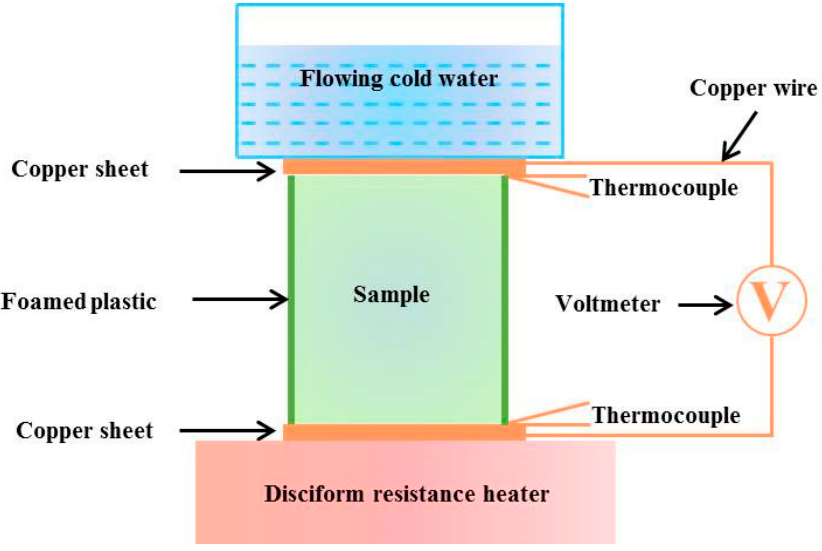
Figure 1. The schematic of the apparatus for measuring Seebeck coefficient around room temperature. The cement-based thermoelectric device mainly included cement-paste blocks (M6), 24 hardened cement-paste blocks (40 × 40 × 160 mm) were connected in series by copper cement-paste block and the copper block to reduce the thermal resistance. In addition, the side of the cement-paste block was covered with a layer of foam insulation to reduce heat loss during heat transfer.